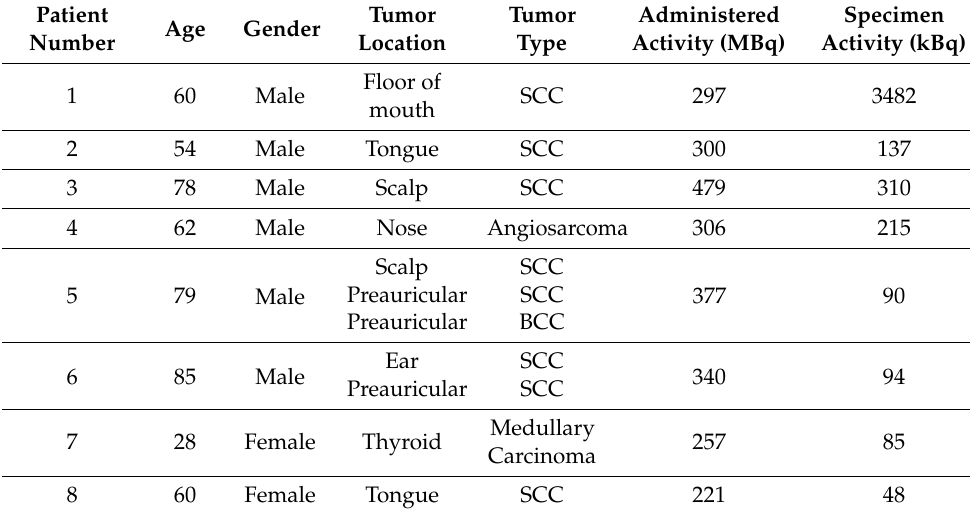
Table 1. Patient characteristics.